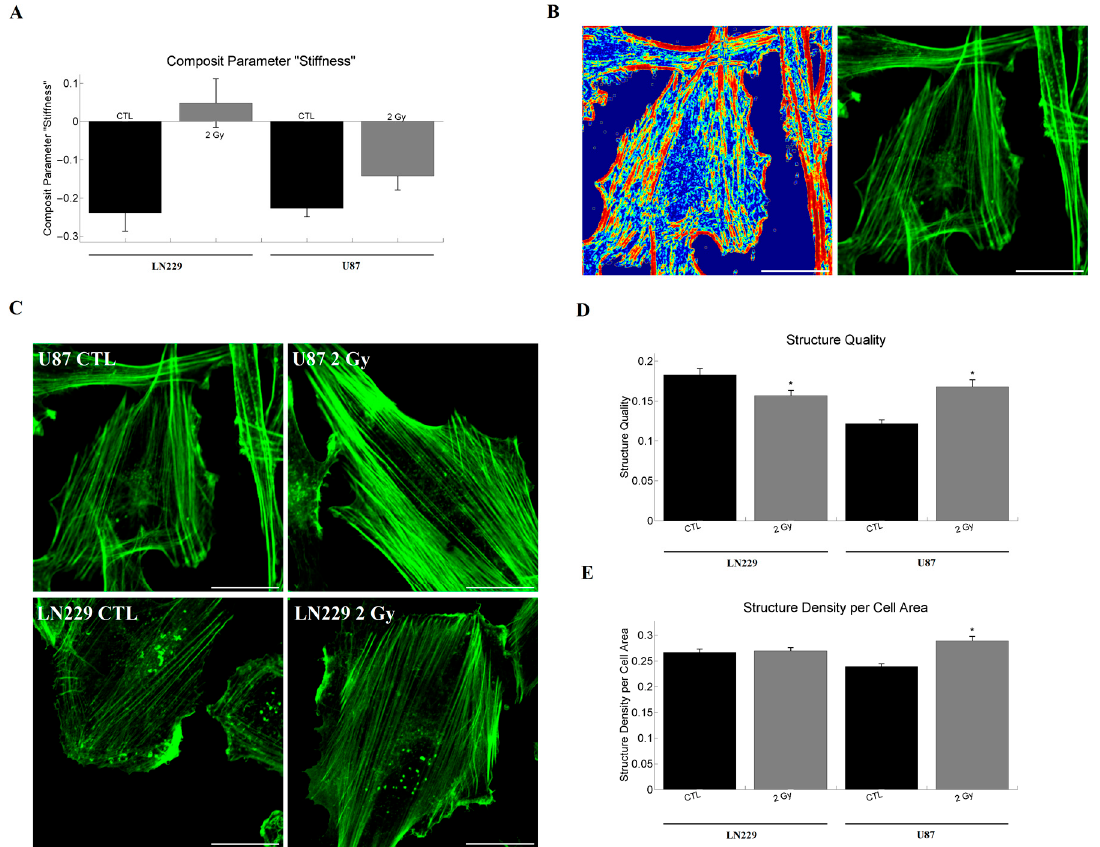
Figure 4. Barplot of the composite parameter “stiffness” and actin structure measurements. ( A ) The composite parameter “stiffness” is in both cases strongly increased after irradiation; ( B ) depicts the structure image as a heat map on the left and the respective phalloidin staining on the right for U87 control cells. A correspondence of highly structured regions in the actin staining with the respective structure image is visible. Furthermore, unstructured, homogeneous regions do not contribute to the structure image, as for example in the center of the image.; ( C ) displays sample images of actin staining for U87 and LN229 cells with and without irradiation. A dense actin network is visible for both cell lines and the respective treatments; ( D ) shows the quantification of the quality of actin structures. A decrease after irradiation is found in the case of LN229 (n CTL = 52; n 2Gy = 66) cells, while an increase is observed for U87 (n CTL = 124; n 2Gy = 94) cells; ( E ) illustrates the changes of actin structure density after irradiation. Only in U87 cells an increase in structure density could be observed. The sample size is identical to the one of the quality measurements. Statistics was performed using the Mann–Whitney test and significance was chosen for p < 0.05. The asterisk denotes significant results regarding the control measurement of the same cell line. The scaling corresponds to 30 µm.